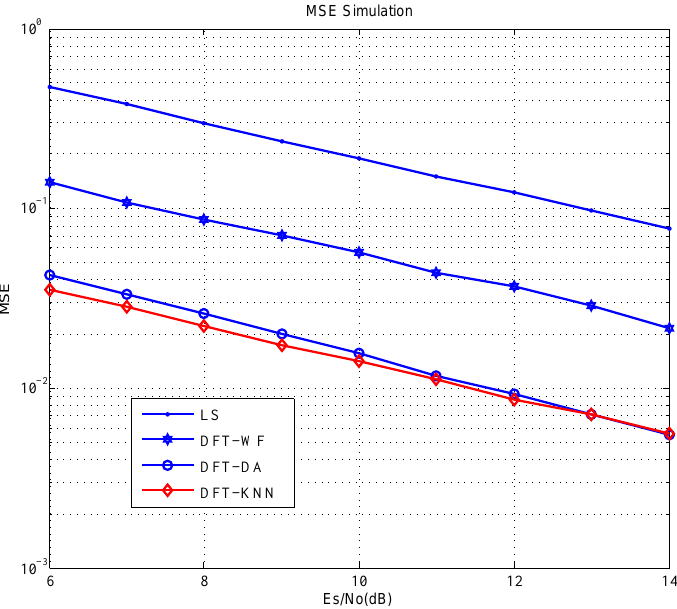
Figure 3. MSE of the channel estimation